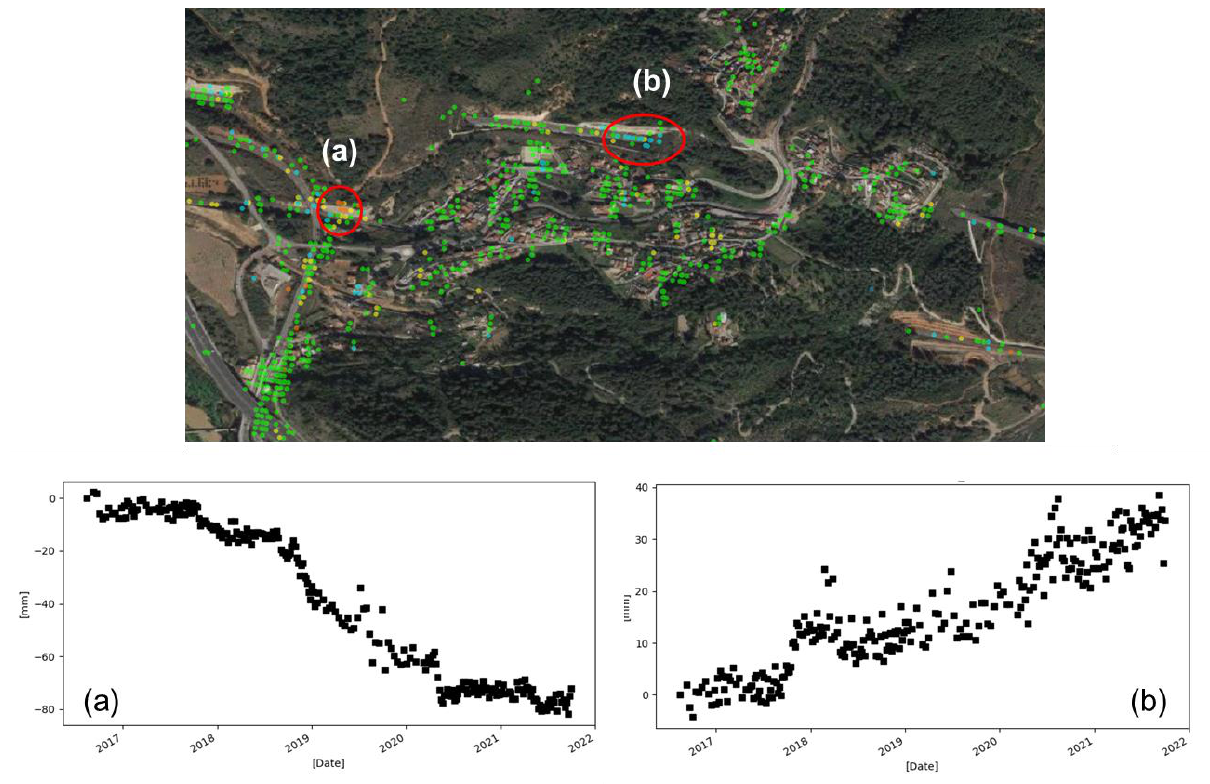
Figure 10. Subsidence and uplift in mountainous areas where tunnels go through